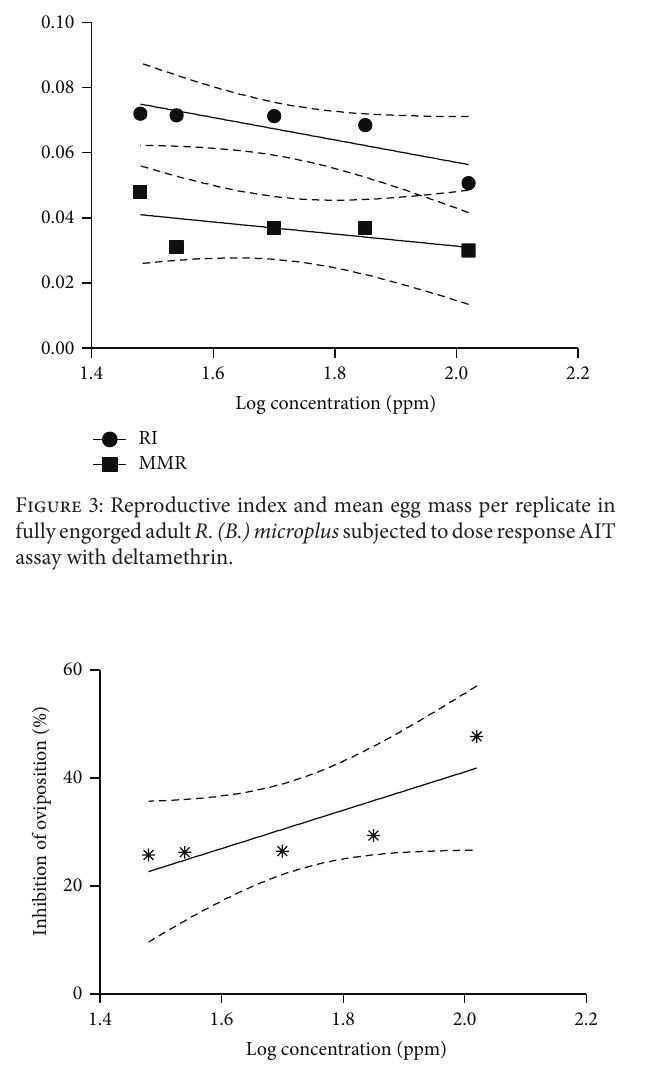
Figure 4: Inhibition of oviposition (IO %) in fully engorged adult R. (B.) microplus subjected to dose response AIT assay with